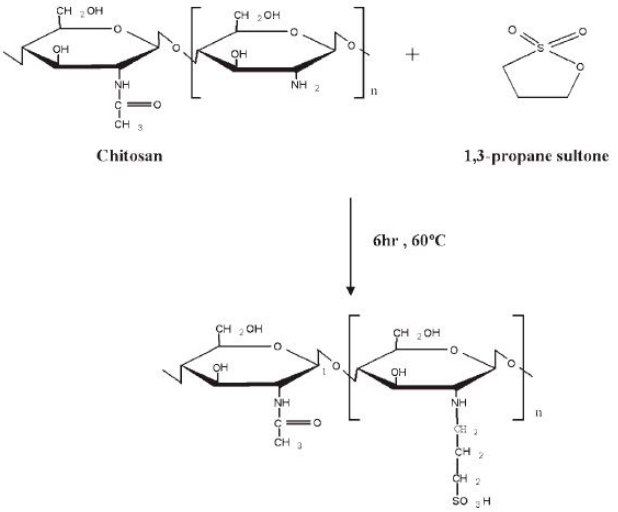
Figure 10. Schematic of the structure of sulphonated CS [152]. Copyright 2010, reproduced with permission from John Wiley and Sons.